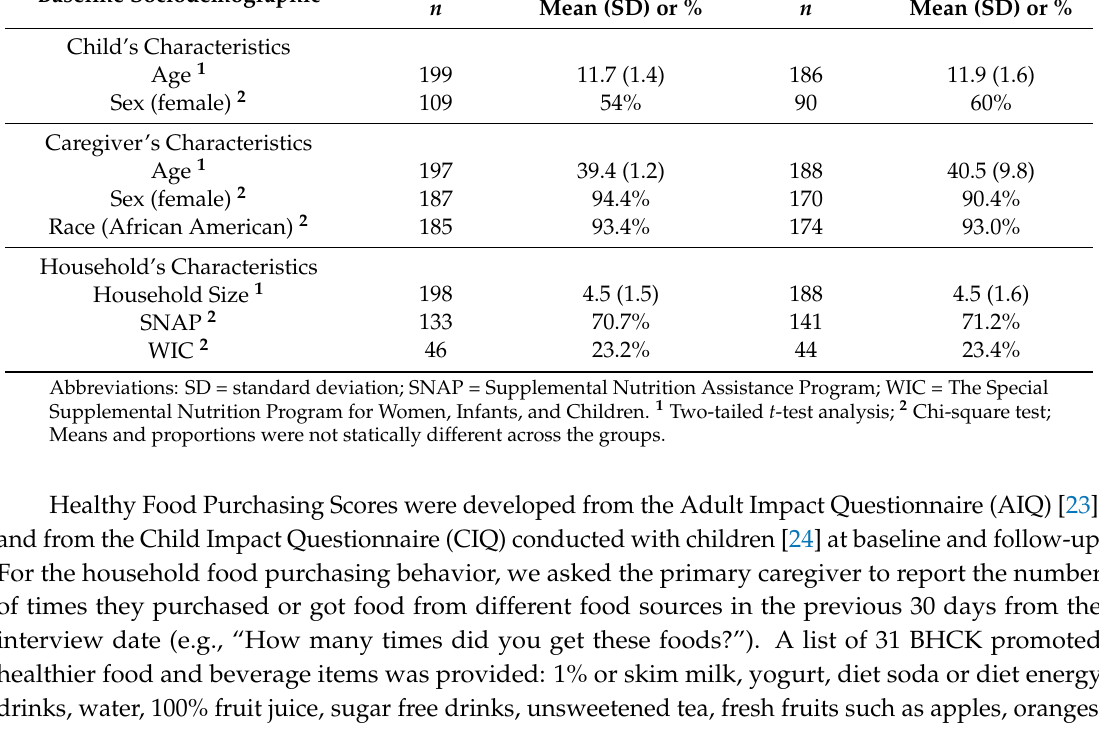
Table 2. Baseline sociodemographic characteristics of BHCK child-caregiver dyads respondents. Intervention Baseline Sociodemographic